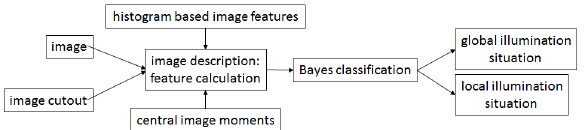
Figure 5: Flow chart for recognizing the illumination situation. For an image or image cutout, an image description is obtained.